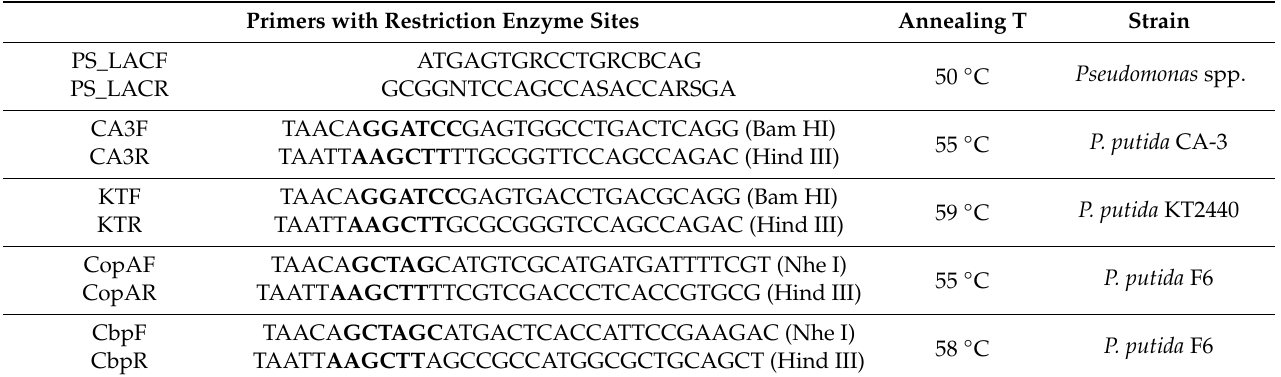
Table 1. Oligonucleotide sequences and the annealing temperaturesused for the amplification of laccases from Pseudomonas species.